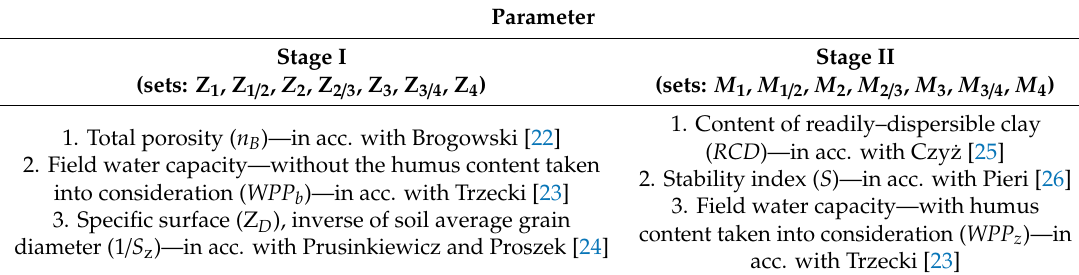
Table 4. Parameters P of stages I and II finally adopted for grouping (see Figure 4).